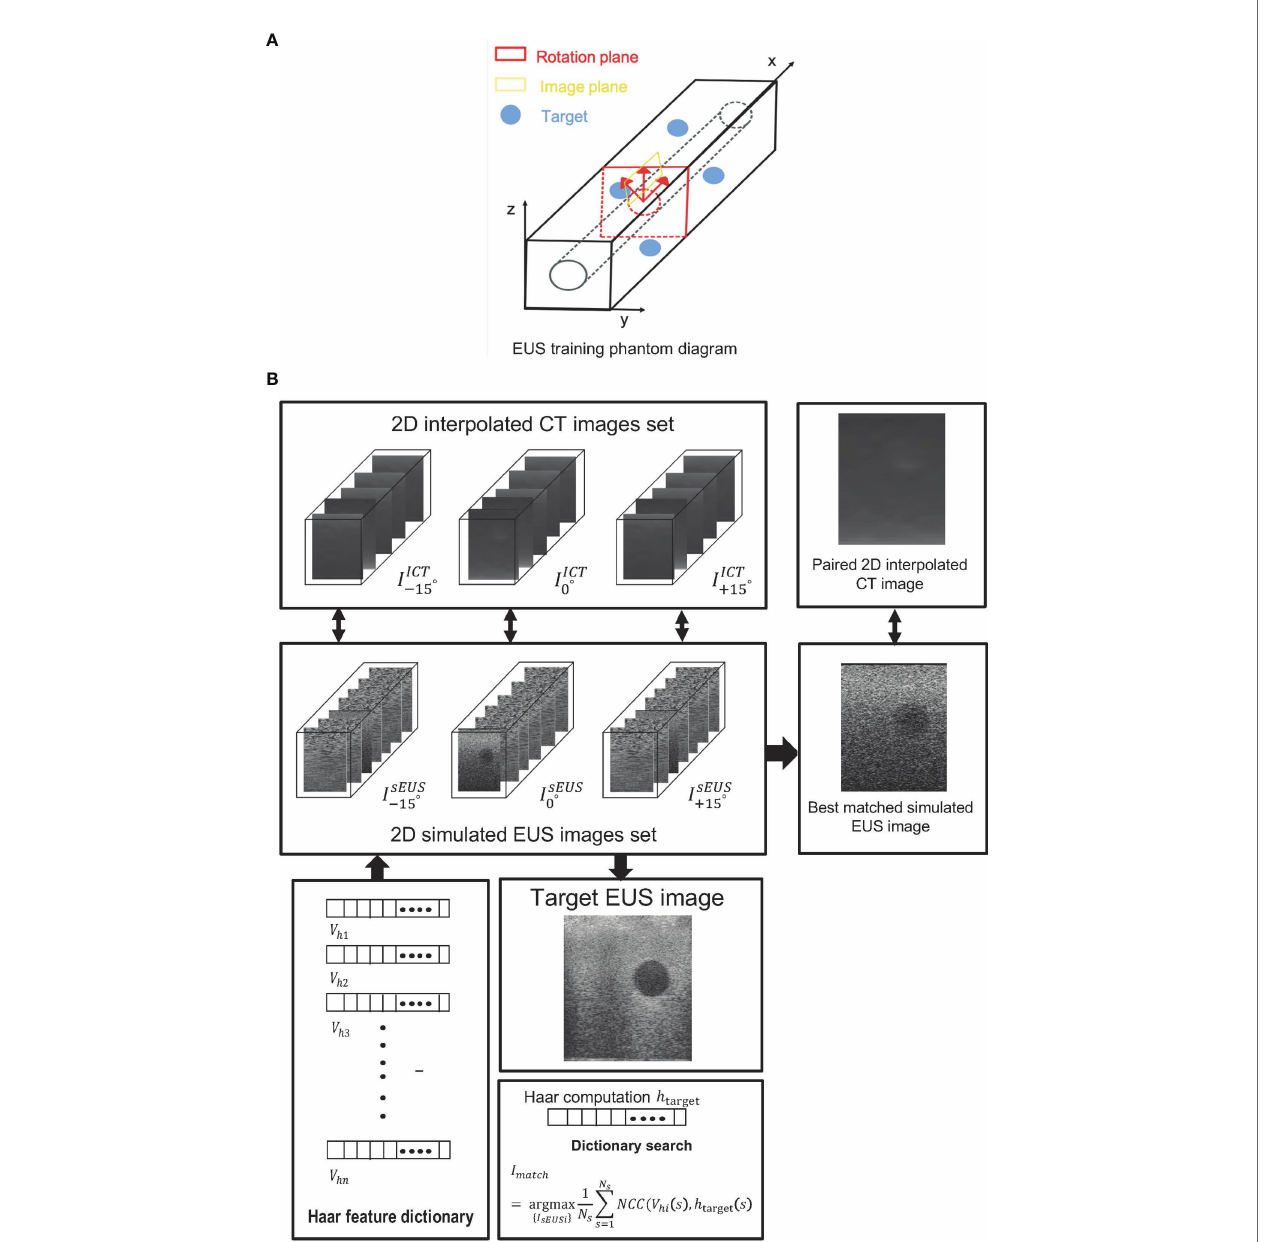
FIGURE 3 | (A) The EUS training phantom and CT interpolated plane diagram. (B) The work fl ow of a phantom